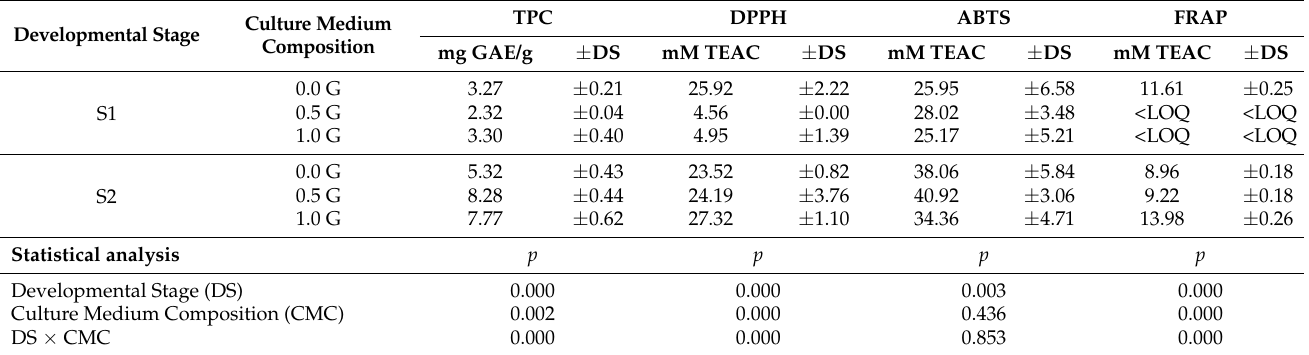
Table 4. Influence of developmental stage and culture medium composition on total